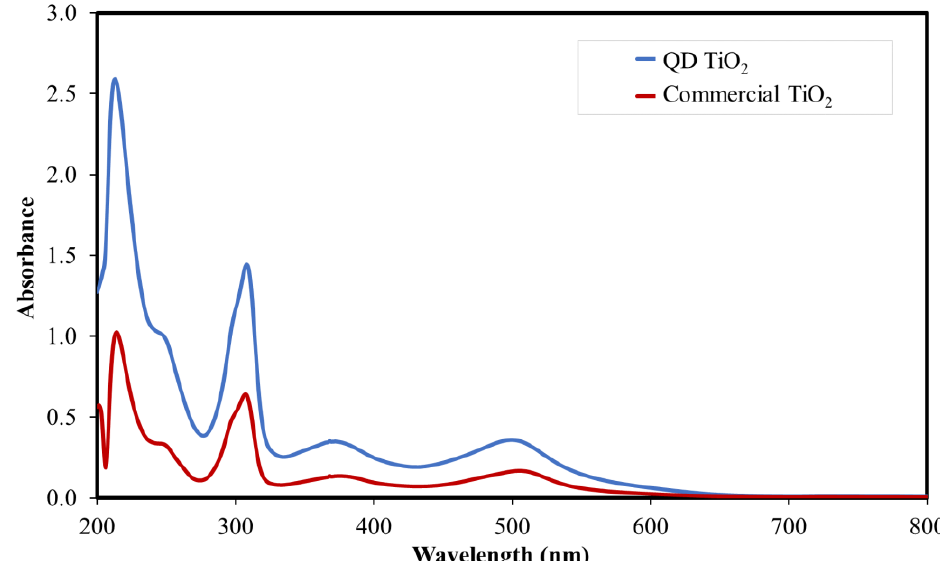
Figure 4. The XRD of the QD TiO 2 and commercial TiO 2 samples printed on FTO substrates.